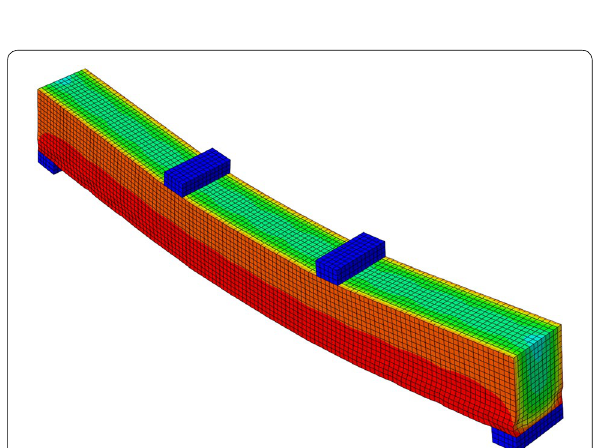
Fig. 16 The flexural capacity simulation of RC beam after fire